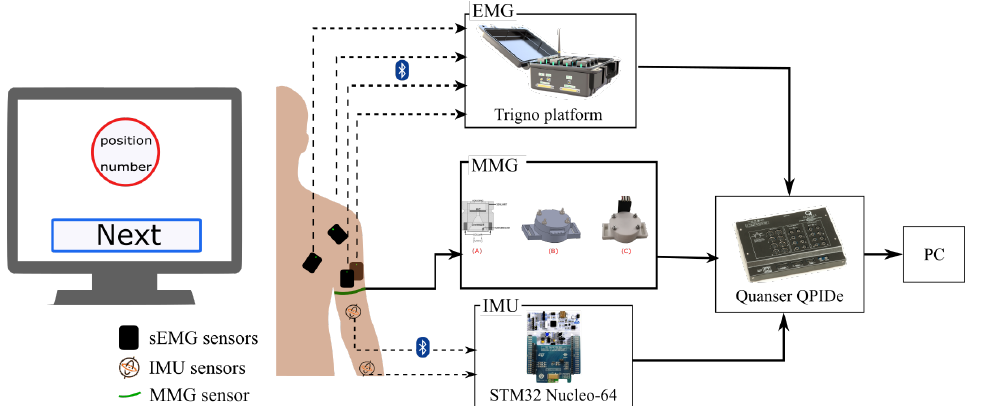
Figure 4. Data acquisition flow: The IMUs and the EMG and MMG sensors were placed on the upper limb of the participant. The EMG and IMU data were transmitted wirelessly, and the MMG data were captured via a wired connection. A DAQ acquires the data (Quanser PIDe) connected to a